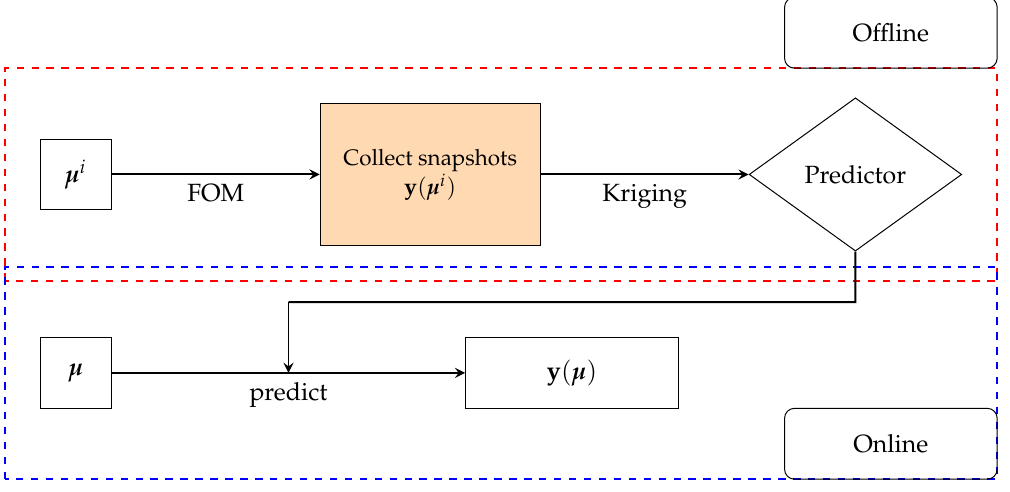
Figure 1. The online and offline procedures of the Kriging approach. FOM, Full-Order